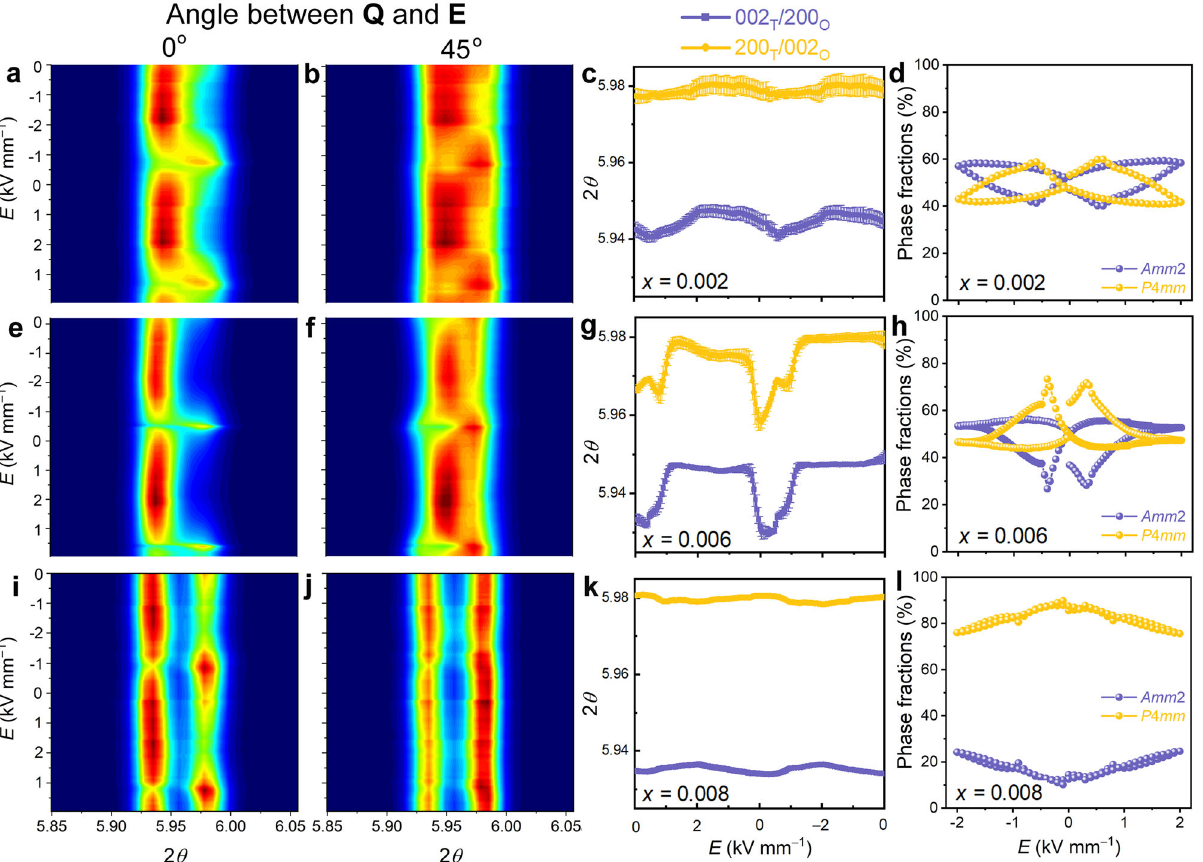
Fig. 2 In situ contour plots of the 200 re fl ections with the electric fi eld. Evolution of the contour plots of the 200 re fl ections in the 0°-sector and 45°- sector, with a bipolar electric fi eld (0 → 2 kV mm − 1 → 0 → − 2 kV mm − 1 → 0) of a , b composition x = 0.002, e , f composition x = 0.006 and i , j composition x = 0.008. Evolution of the peak positions of the 200 re fl ections for c composition x = 0.002, g composition x = 0.006, and k composition x = 0.008 with bipolar electric fi eld, obtained from the 45°-sector. Phase fractions of the orthorhombic and tetragonal phases as a function of the applied bipolar fi eld of d composition x = 0.002, h composition x = 0.006, and l composition x = 0.008, calculated using a method that allows the analysis of all strain mechanisms with a Strain, Texture, and Rietveld Analysis for Piezoceramics (STRAP) 44 . The wavelength of the used X-rays is 0.20714